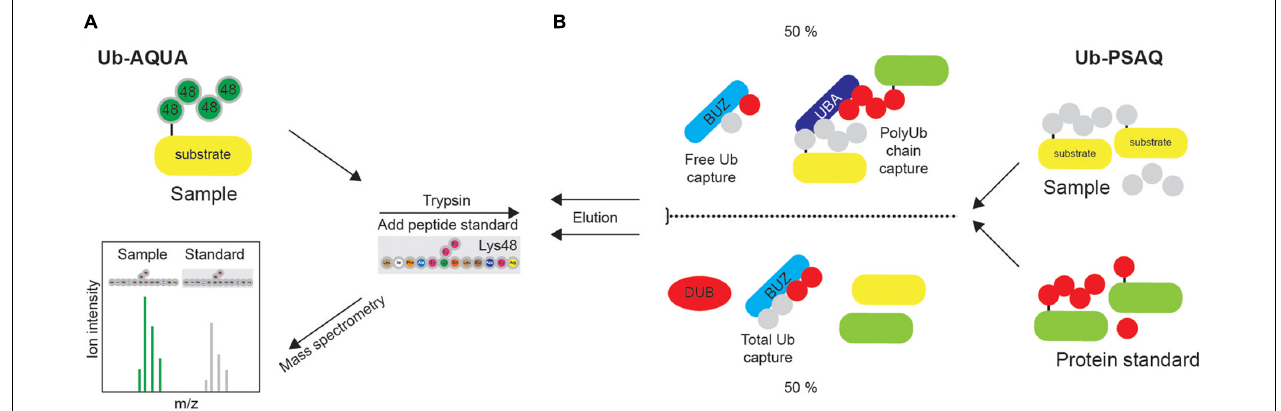
FIGURE 8 | Quantification of ubiquitination in vivo. (A) Synthetic peptide absolute quantification (Ub-AQUA) MS approach is based on synthetic peptides as quantification standards for both mono- and polyubiquitination. (B) Ub-PSAQ approach is based on the use of stable isotope-labeled free Ub and Ub conjugates as protein standards. They are added to lysates and captured with UBD BUZ that is selective for free Ub and UBD PLIC2 UBA (or similar) that recognizes Ub chains. Half of the sample is treated with USP2cc and total free Ub captured by BUZ affinity reagent. Sample is quantified by MS, relative to the peptide